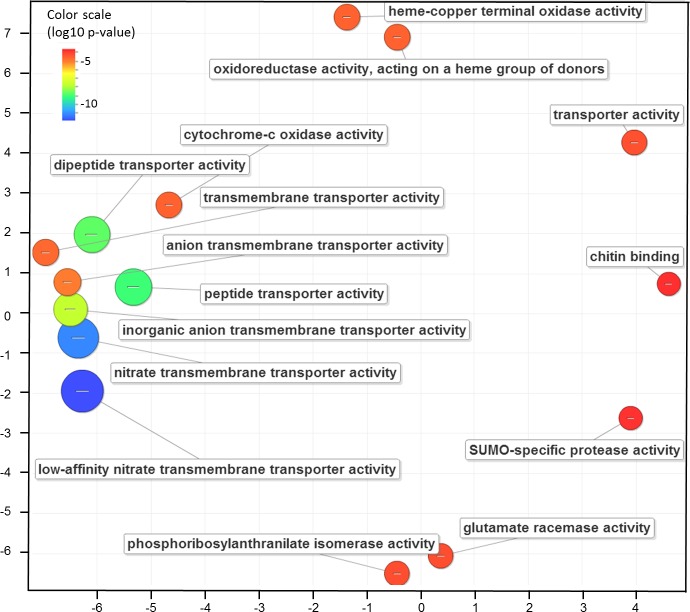
Summarization and visualization of enriched GO terms of NAT pairs in tomato fruits.The scatterplot shows the representative clusters (made of enriched GO terms of Table E in S1 File after the redundancy reduction) in a two dimensional space derived by applying multidimensional scaling to a matrix of the GO terms' semantic similarities (more semantically similar GO terms are closer). Bubble color indicates the p-value according to the legend in upper left-hand corner. Bubble size is scaled according to the frequency of the GO terms.